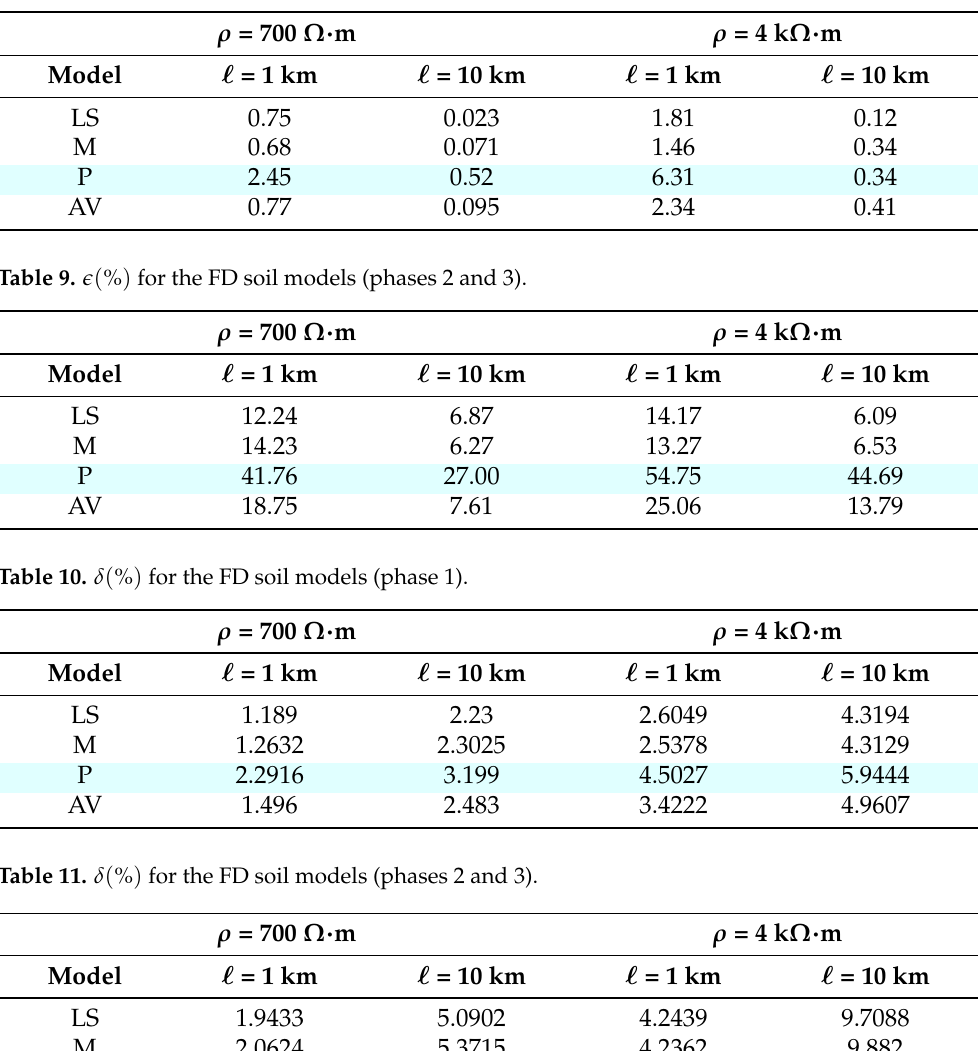
Table 8. (cid:101) ( % ) for the FD soil models (phase 1).